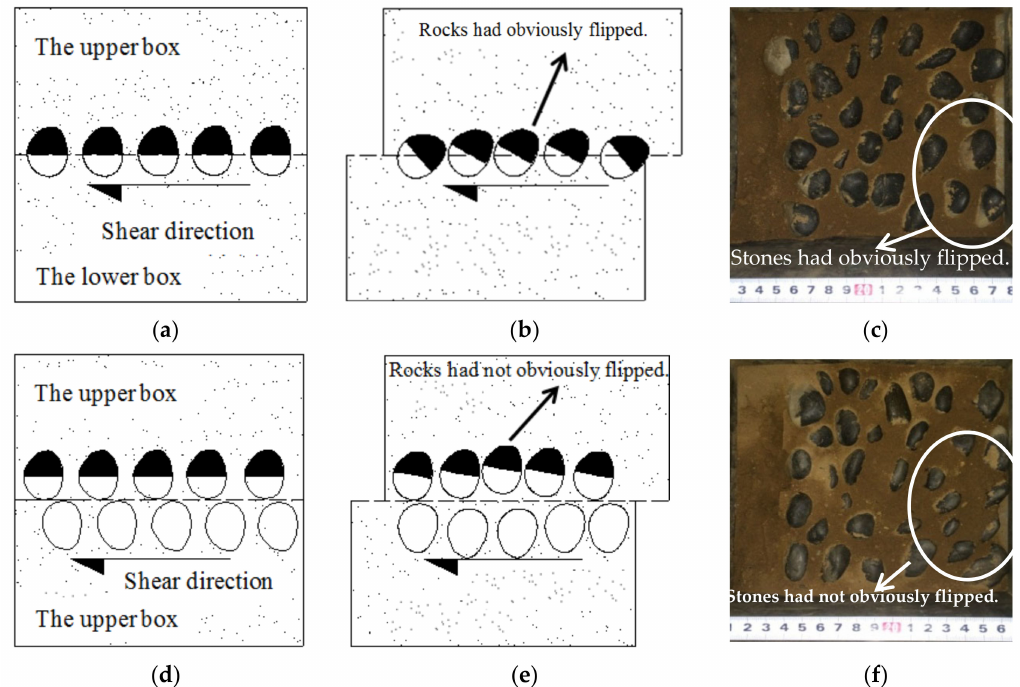
Figure 17. Deformation characteristics of block stones throughout the shear plane. ( a ) Single row of stones throughout shear plane, ( b ) location of these stones after shearing, ( c ) vertical view of the stones after shearing, ( d ) double row of stones throughout the shear plane, ( e ) location of these stones after shearing, ( f ) vertical view of the stones after